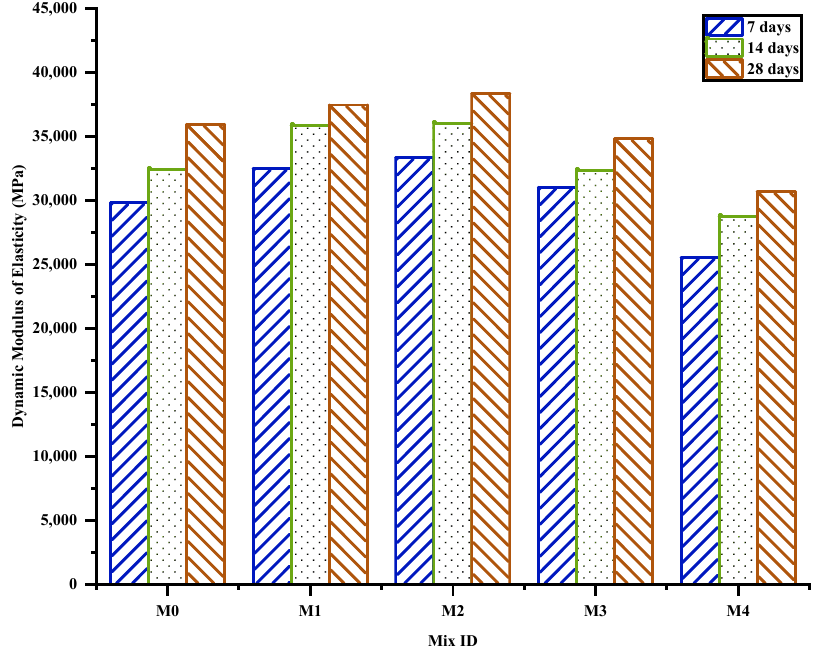
Figure 6. Dynamic modulus of elasticity of fine-grained cementitious composites for five different mixes.